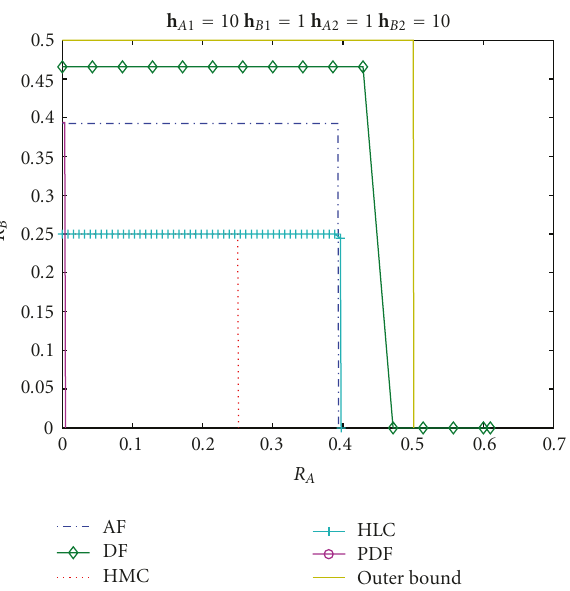
Figure 7: The achievable rate regions and the outer bound.